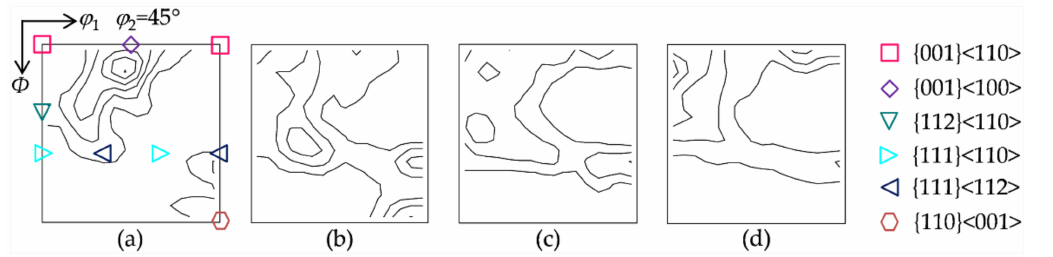
Figure 2. Constant ϕ 2 = 45 ◦ section of the ODFs (levels: 1, 2, 3 . . . ) for the four initial textures: ( a ) initial texture I, ( b ) initial texture II, ( c ) initial texture III, and ( d ) initial texture